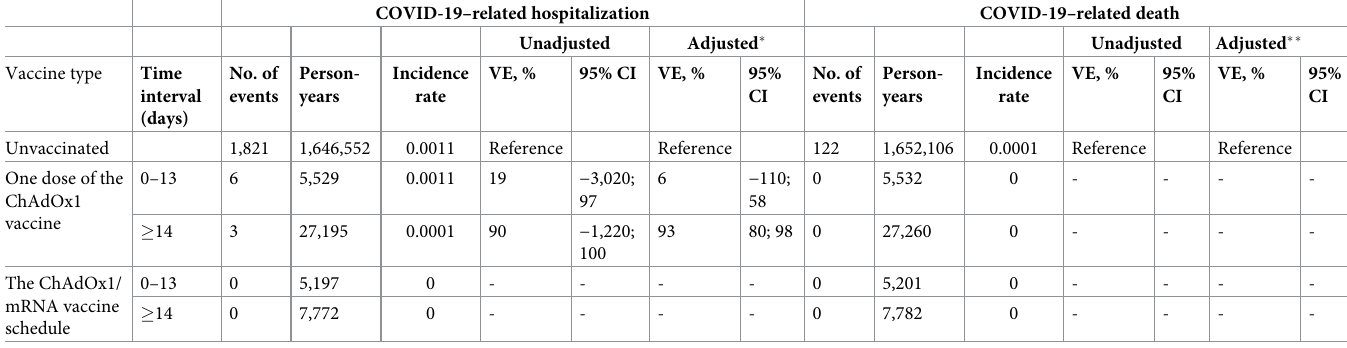
Table 3. Unadjusted and adjusted VE estimates against COVID-19–related hospitalization and death of 1 dose of the ChAdOx1 vaccine and the ChAdOx1/mRNA vaccine